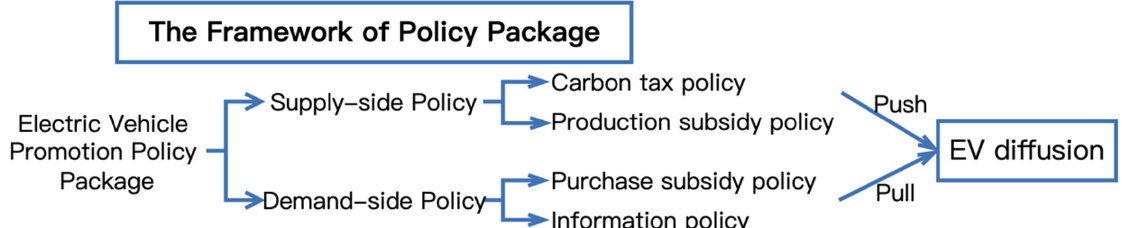
Figure 1. The framework of EV promotion policy package.